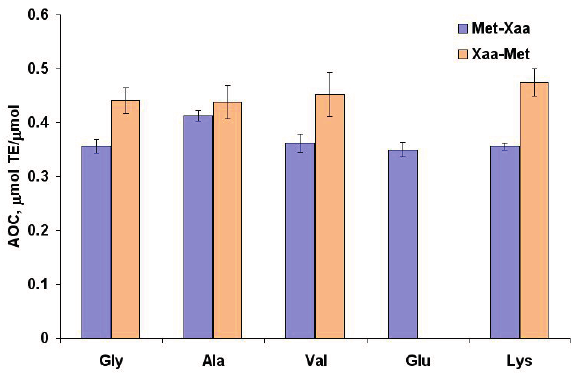
Figure 4. Antioxidant capacity of methionine dipeptides against peroxyl